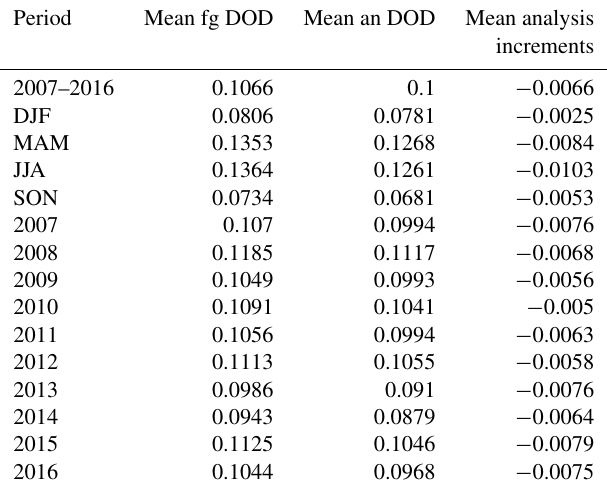
Table 3. Averaged DOD of first guess (fg), analysis (an) and analy- sis increments (an-fg) for the full period (2007–2016), for different seasons (DJF, MAM, JJA, SON) and for individual